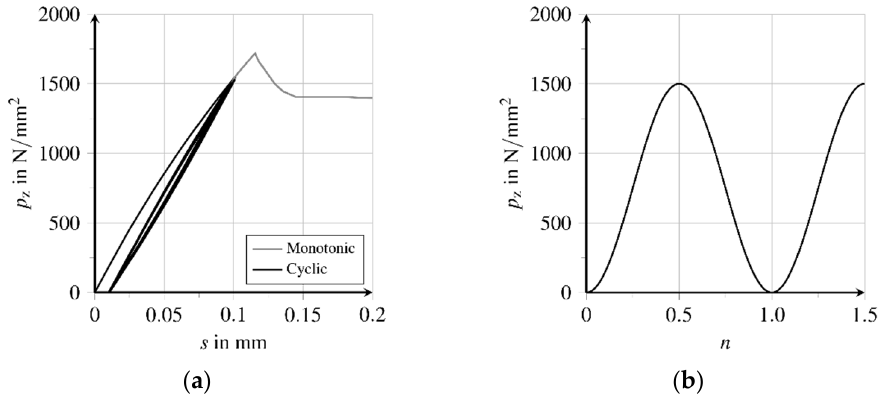
Figure 10. Simulation of cyclic tensile loading (adapted from [27]): ( a ) Loading over slip relation and ( b ) sinusoidal tensile cyclic loading function.